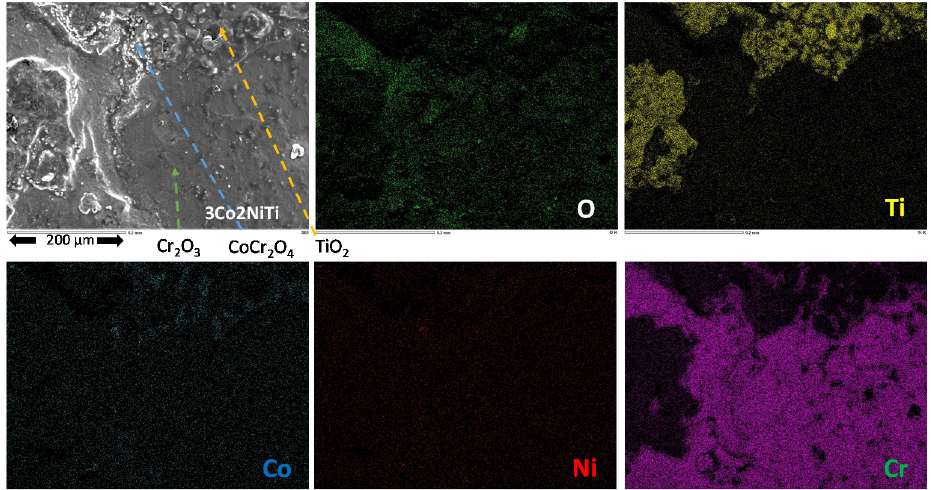
Figure 7. X-map obtained on the oxidized surface zone of the 3Co2NiTi alloy (evidencing the TiO 2 , CoCr 2 O 4 and Cr 2 O 3 zones).